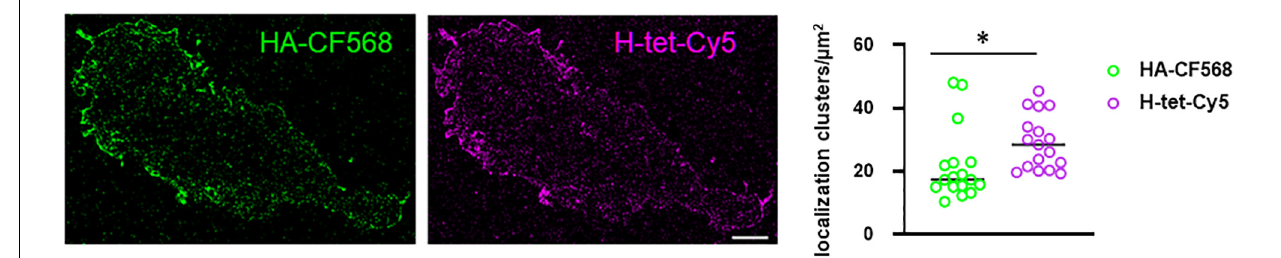
FIGURE 4 | d STORM images of immunolabeled HA-tag modified (HA-CF568) and click-chemistry labeled S181TAG GABA-A receptor α 2 subunits (H-tet-Cy5) in the same HEK-293-T cell. Cluster analysis applying a DBSCAN algorithm demonstrates that H-tet-Cy5 labeling (magenta) exhibits a higher labeling density (localization clusters/ µ m 2 ) than immunolabeling with anti-HA-CF568 antibodies (green); lines represent median, p = 0.005 ( n = 17, non-parametric Mann–Whitney U test). Scale bar: 2 µ m. Significance level ∗ p ≤